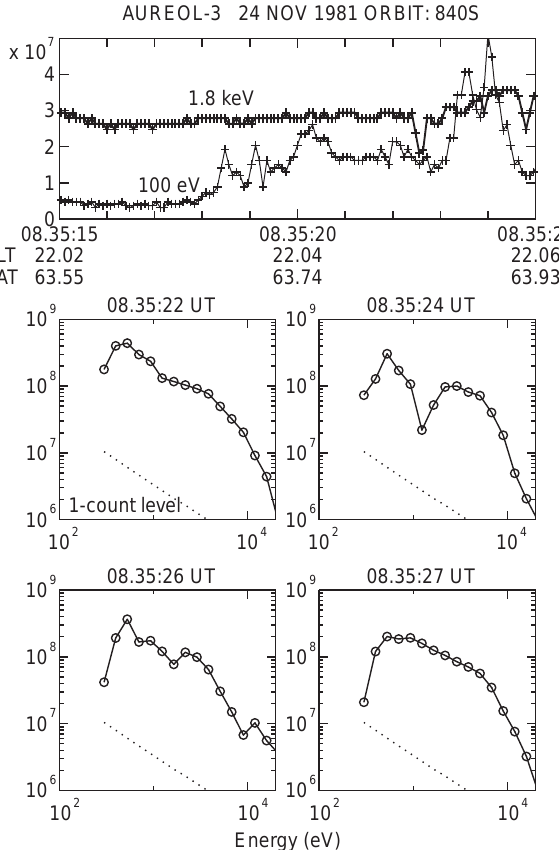
Fig. 3a–d. A3 measurements during pass 840S: a DB and DB x y variations (nT) of the horizontal magnetic field measured by the Fig. 4. Electron precipitation in the auroral arc detected between TRAC magnetometer, after subtraction of the background magnetic 0835:18 and 0835:25 UT. Top : expanded view of the electron fluxes at field ( DB along the orbital direction, DB perpendicular to it, 100 eV ( light curve ) and 1.8 keV ( bold curve ) measured by the RIEP x y sampling rate: 80 ms, running averages on 1.2 s); b electron instrument; middle and bottom : four successive electron di(cid:128)erential di(cid:128)erential fluxes (cm 2 s sr keV) ) 1 at 2 fixed energies, 100 eV and spectra measured by the ROT_5 sensor, starting at 0835:22 UT. 1.8 keV ( bold curve , flux divided by 10), given by the RIEP Di(cid:128)erential fluxes are expressed in (cm 2 s sr keV) ) 1 units and the 1- spectrometer (pitch angle: (cid:24) 50 (cid:176) ; sampling rate: 80 ms; running count level for the ROT sensor is indicated in each panel by a dotted averages on 1.2 s); c proton di(cid:128)erential fluxes at 100 and 1.8 keV ( bold curve , flux divided by 10); d electron density N (cm ) 3 ) and e temperature T ( (cid:176) K) measured by the ISOPROBE instrument (same e scale). The region of the weak auroral arc is indicated in a and b by a vertical grey band. See text for vertical arrows in panel c